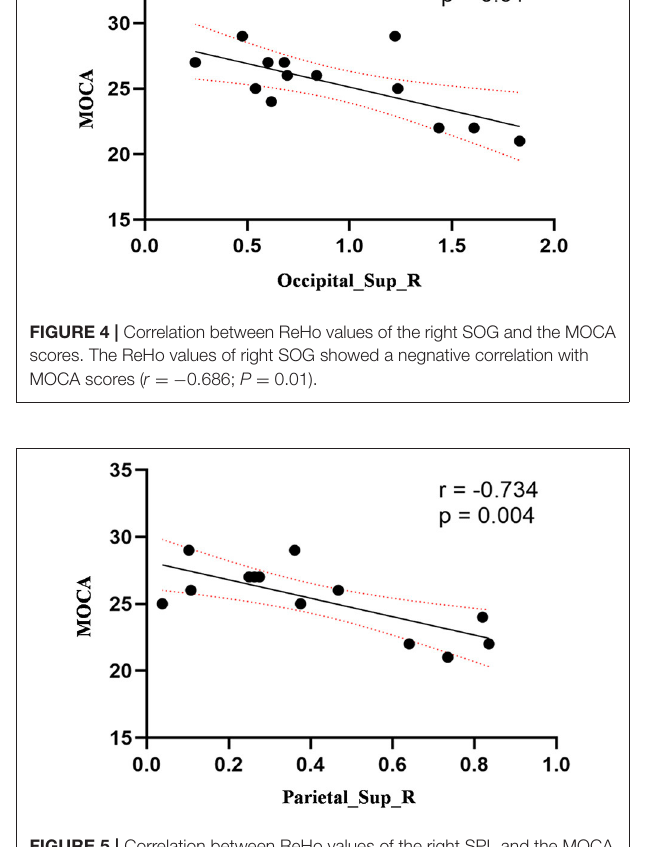
FIGURE 5 | Correlation between ReHo values of the right SPL and the MOCA scores. The ReHo values of right SPL showed a negnative correlation with MOCA scores ( r = − 0.734; P = 0.004).